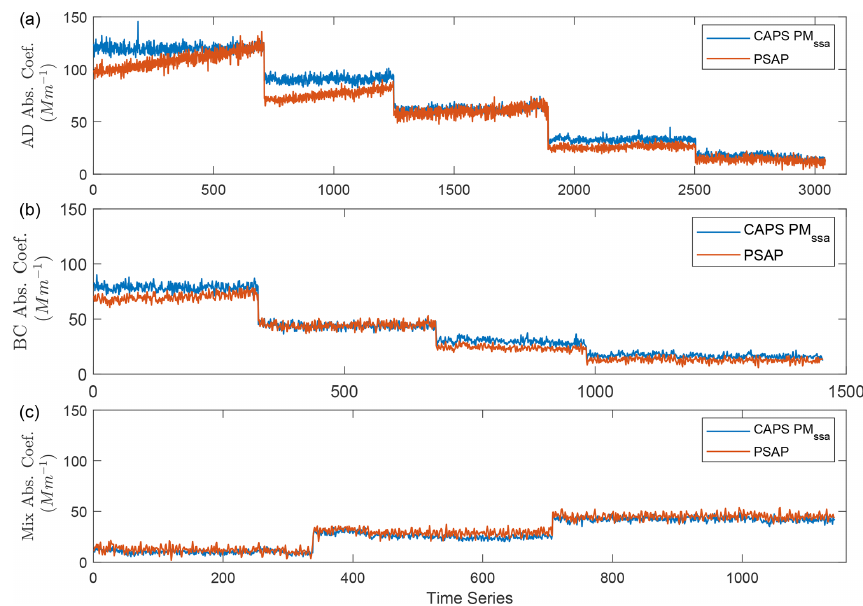
Figure 10. Time series (1Hz) (in seconds; 1s resolution) of the simultaneously measurements of the absorption coefficient for the different test aerosols ( a Aquadag AD, b BC, c mix) by the PSAP and the CAPS PM SSA (as a result of the subtraction of σ sp from the extinction coefficient).